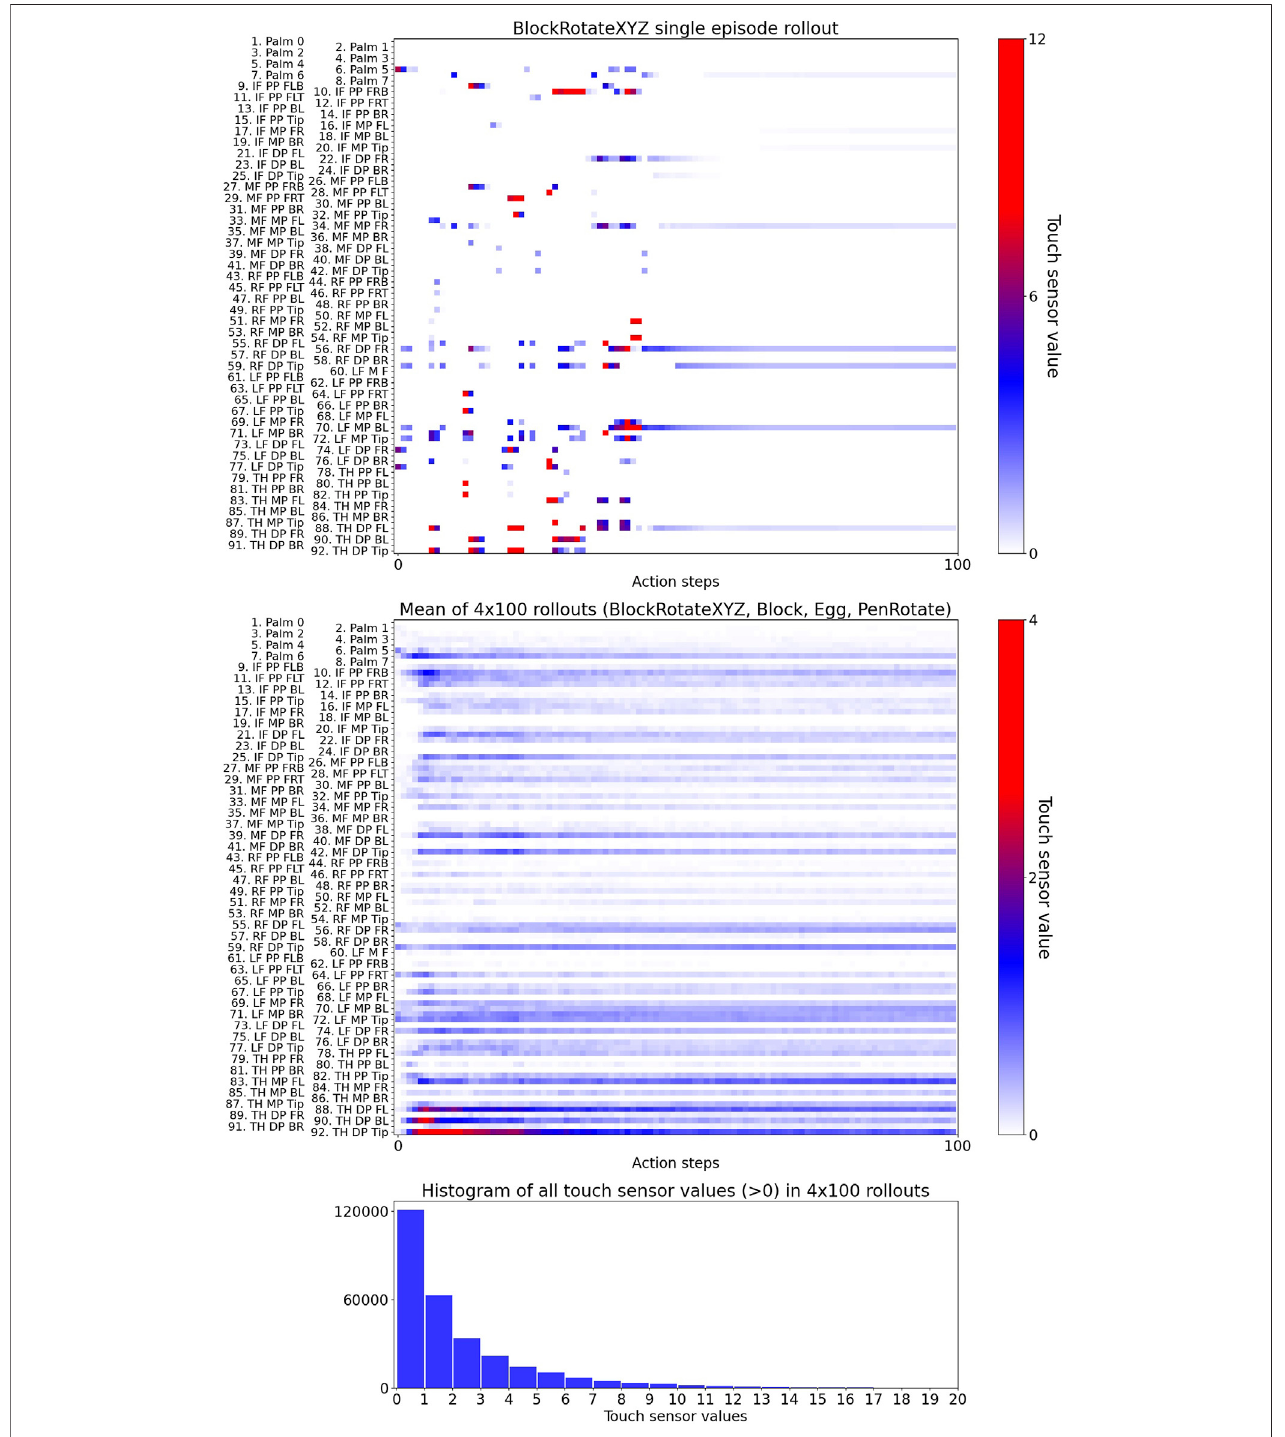
FIGURE 3 | Visualisation of touch-sensor values in a single episode rollout (upper plot), mean of 400 rollouts (middle plot), and a histogram of all touch-sensor valuesin the 400 rollouts. IF -Index Finger, MF - Middle Finger, RF - Ring Finger, LF- Little Finger, DP -Distal Phalanx, MP -Middle Phalanx,PP -ProximalPhalanx, FL- Front Left, FLB - Front Left Bottom, FLT - Front Left Top, FR - Front Right, FRB - Front Right Bottom, FRT - Front Right Top, BL - Back Left, BR - Back Right.